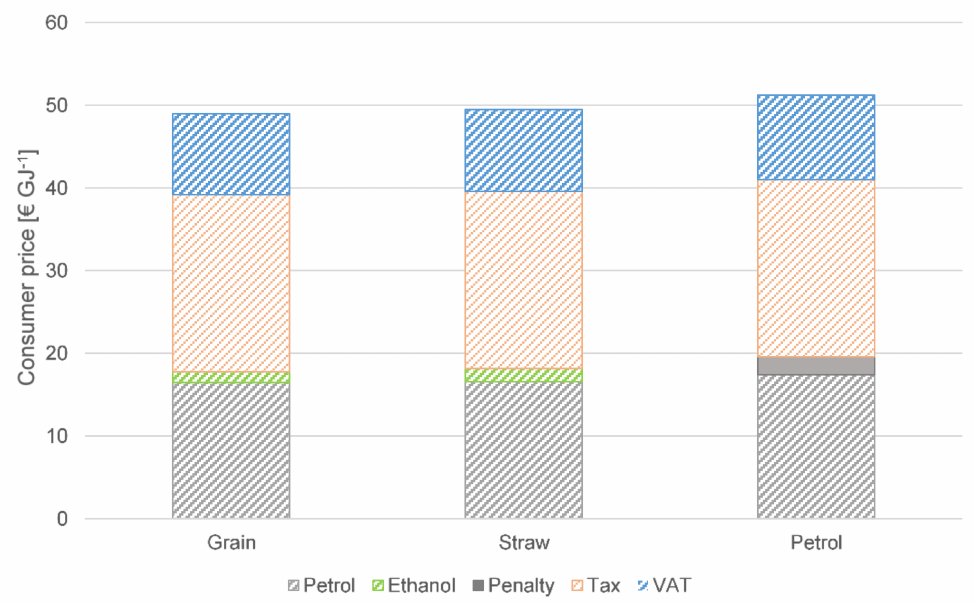
Figure 9. Consumer price for petrol including low-blend of ethanol from grain or straw based on the Swedish low blend reduction mandate for